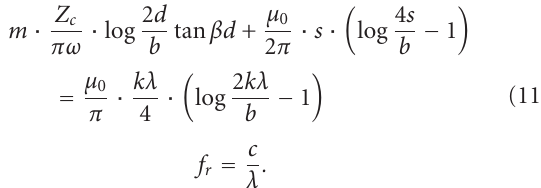
Figure 4: The third Peano fractal antenna: (a) front face of antenna, (b) back of antenna.